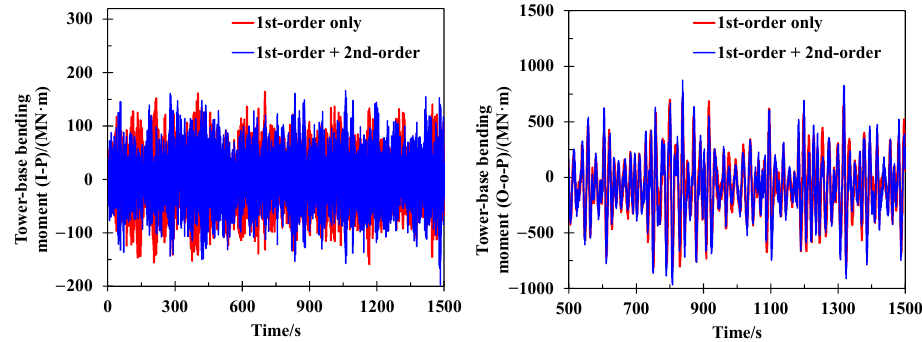
Figure 11. Time − varying tower − base bending moments under the extreme condition with and without considering the second − order wave excitations.